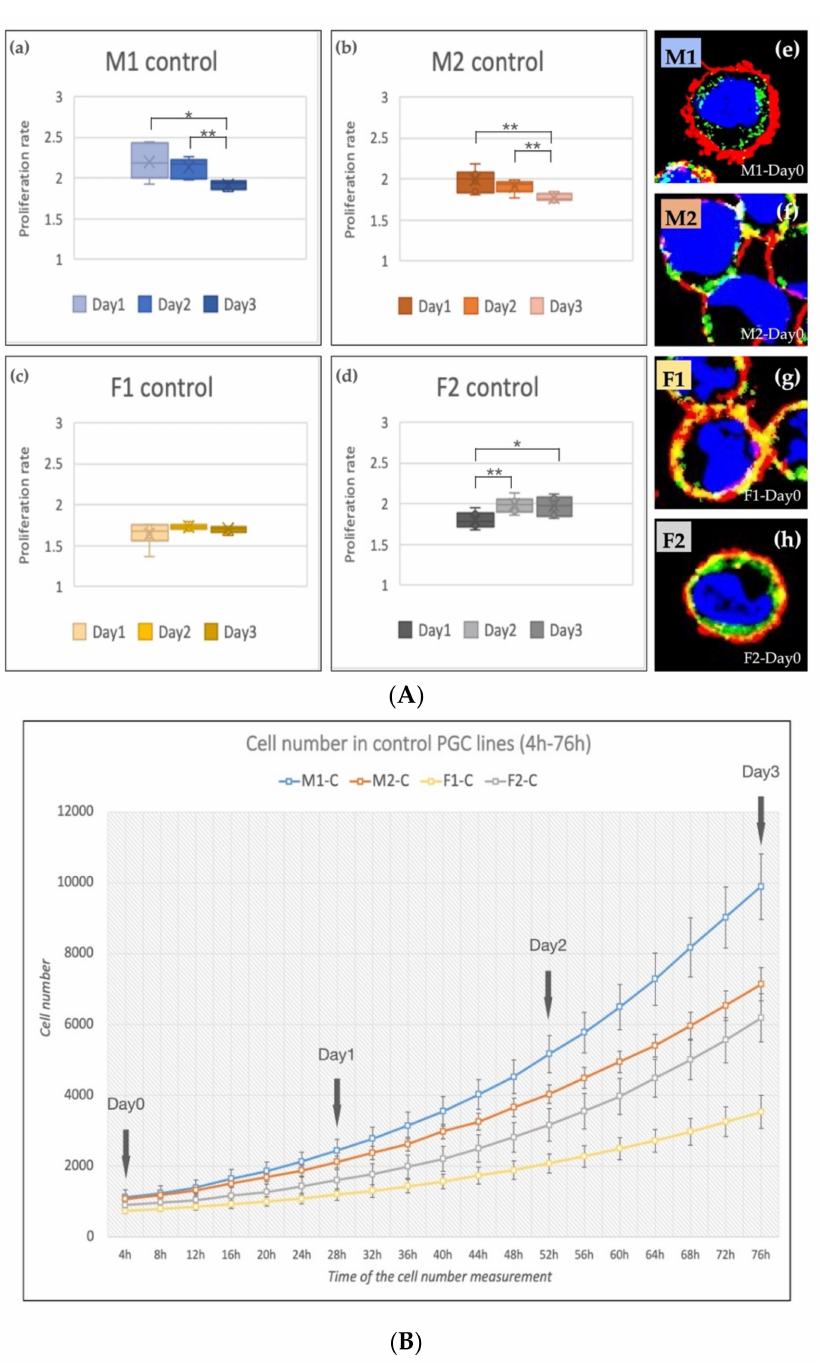
Figure 3. ( A ) The proliferation rate of the control PGC lines on Day 1, Day 2 and Day 3 ( a – d ) and immunostaining ( e – h ) of the four lines are shown in the figure. The immunostaining was achieved with SSEA-1 (red), CVH (green) and TO-PRO™-3 for nuclear staining (blue). ( B ) Analysis of the cell number. The cell number measurements were performed every 4 h (from 4 h to 76 h). We calculated the proliferation rates on Day 1, Day 2 and Day 3 ( p < 0.05 *, p < 0.01